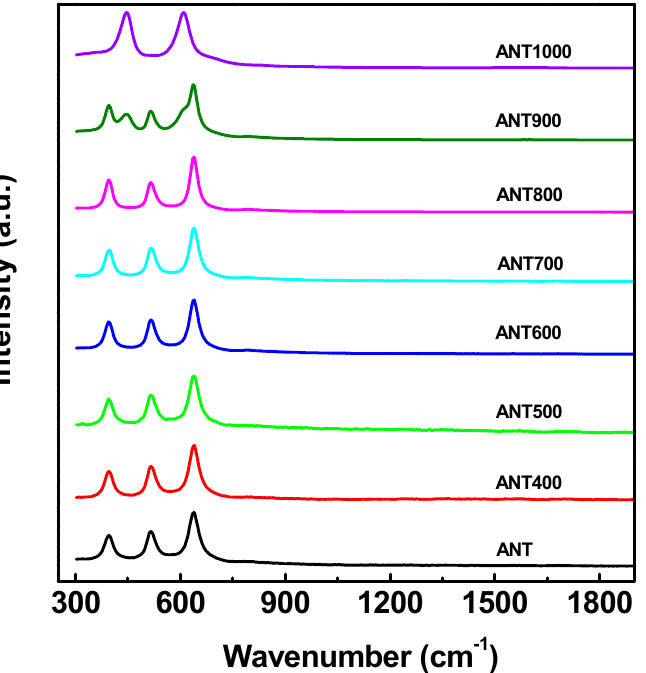
Figure 4. Raman spectrum of anatase TNPs annealed at different temperatures.